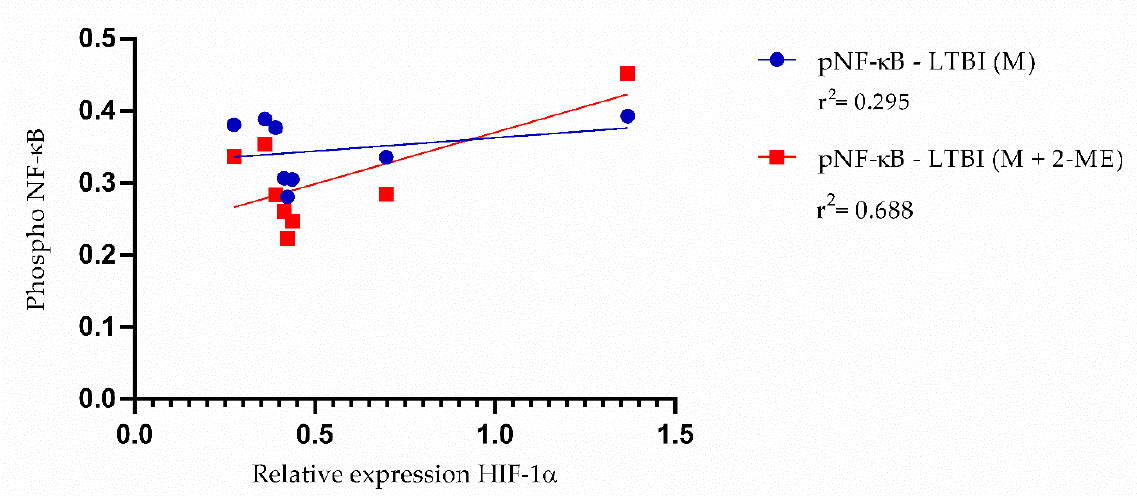
Figure 5. Correlation between expression of phosphorylated NF- κ B and gene expression of HIF1A in individuals with LTBI. Significant correlations between gene expression of HIF1A and expression of phosphorylated NF- κ B were represented by Pearson’s correlation: r 2 = 0.2951 for pNF- κ B–LTBI (medium alone), with 95% confidence interval ( − 0.5171 to 0.8276); and r 2 = 0.6889 for pNF- κ B–LTBI (medium + 2-ME), with 95% con fi dence interval ( − 0.03070 to 0.9381). Abbreviations: pNF- κ B, phos- phorylated NF- κ B; LTBI, latent tuberculosis infection; M, medium; 2-ME, 2-methoxyestradiol.